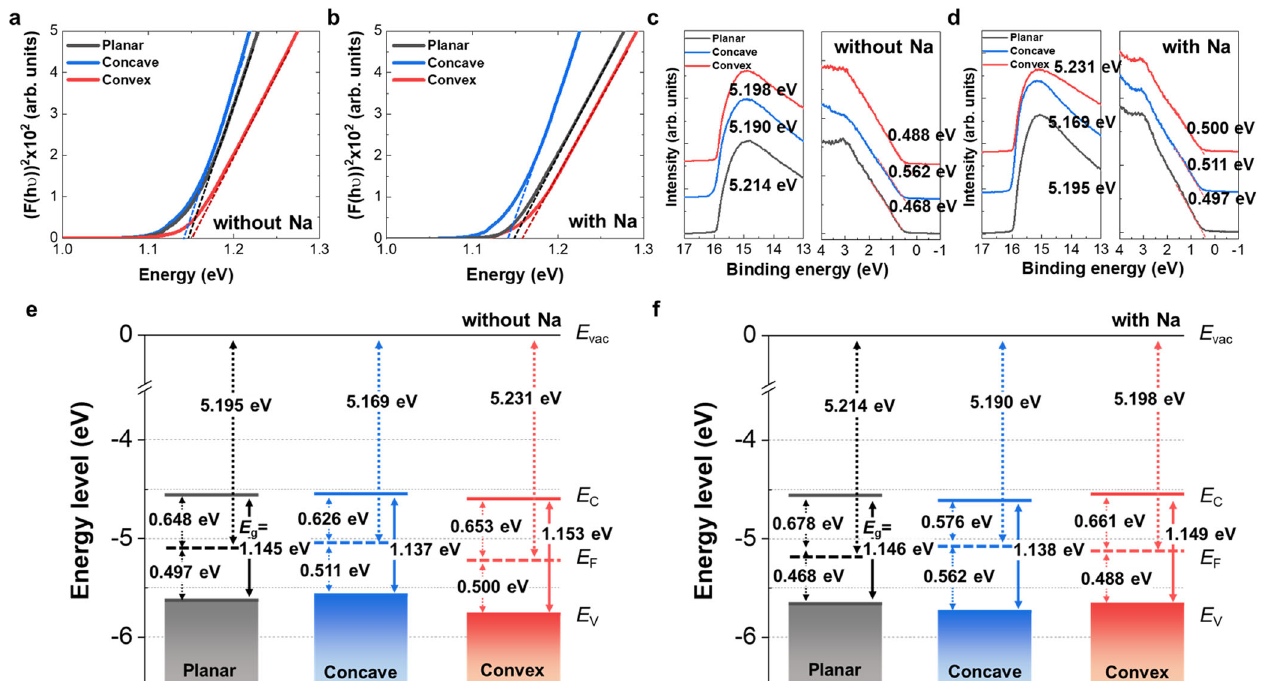
Fig. 1 Changes in electronic band structure with mechanical stress. a , b Tauc plot obtained from diffuse re fl ectance spectroscopy (DRS). c , d Valence band edge and work function of CZTSSe ( c ) without and ( d ) with Na elements under planar, concave, convex bendings. e , f Schematic band diagram of CZTSSe ( e ) without and ( f ) with Na elements under planar, concave, convex bending states. E vac , E F , E C , and E V are vacuum, Fermi, conduction, valence level,